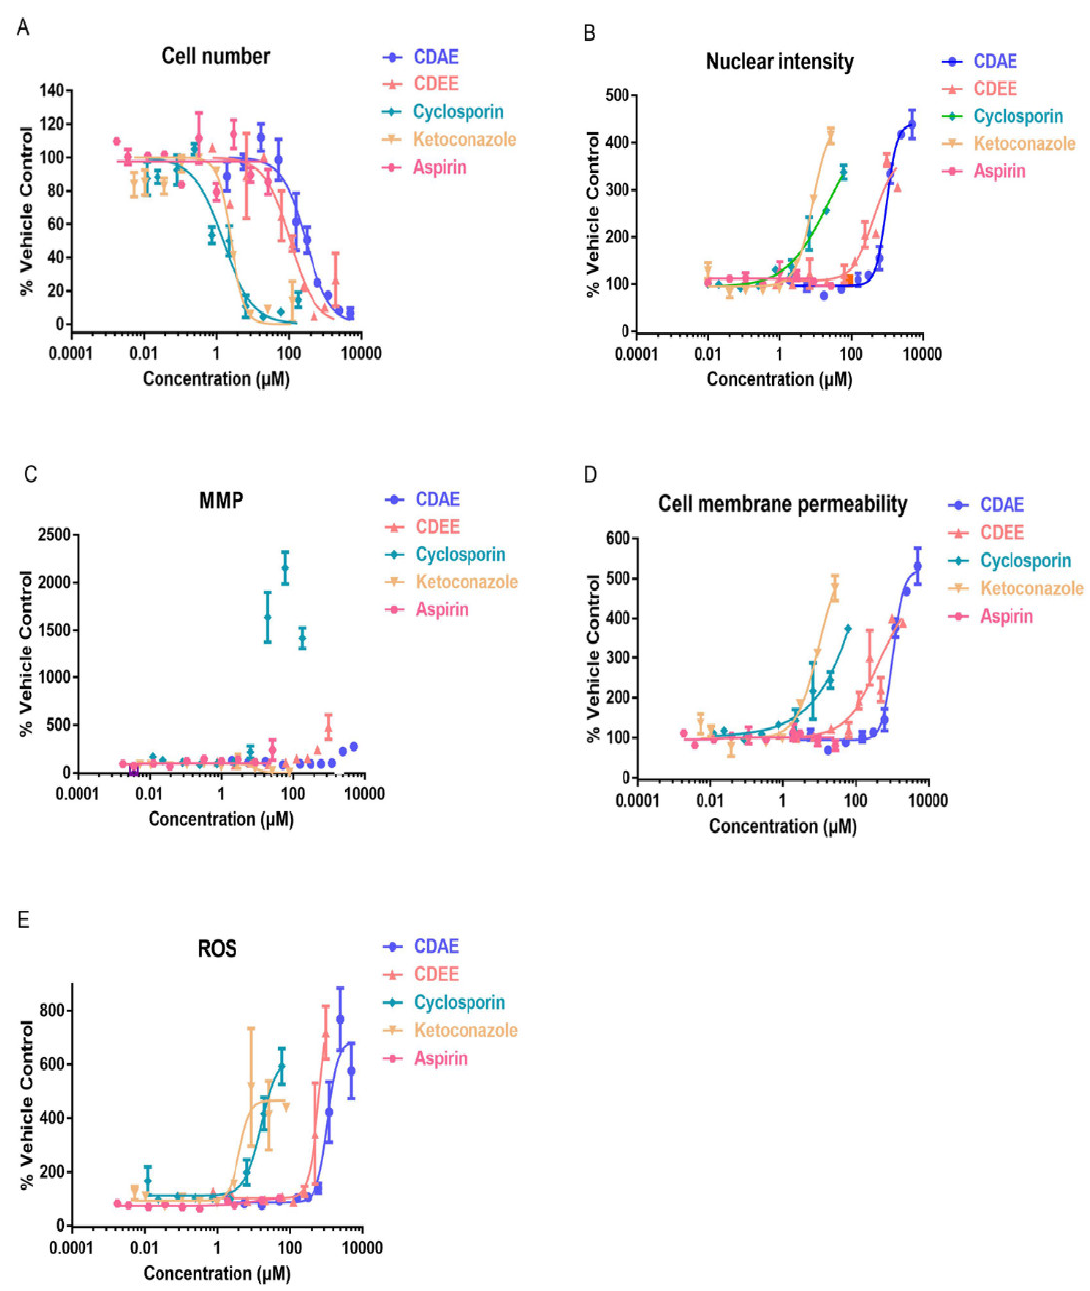
Figure 6. Estimation of drug-induced liver toxicity of CDAE and CDEE using a high content imaging assay. ( A ) Cell number; ( B ) nuclear intensity; ( C ) mitochondria membrane potential (MMP); ( D ) cell membrane permeability; and ( E ) reactive oxygen species (ROS).